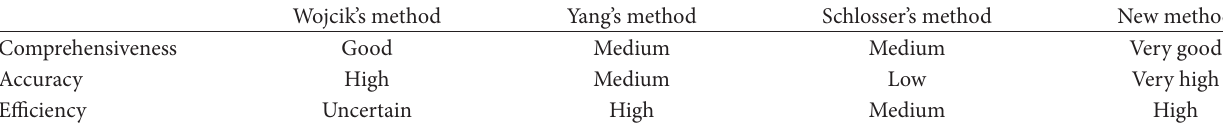
Table 3: The comparison of the previous